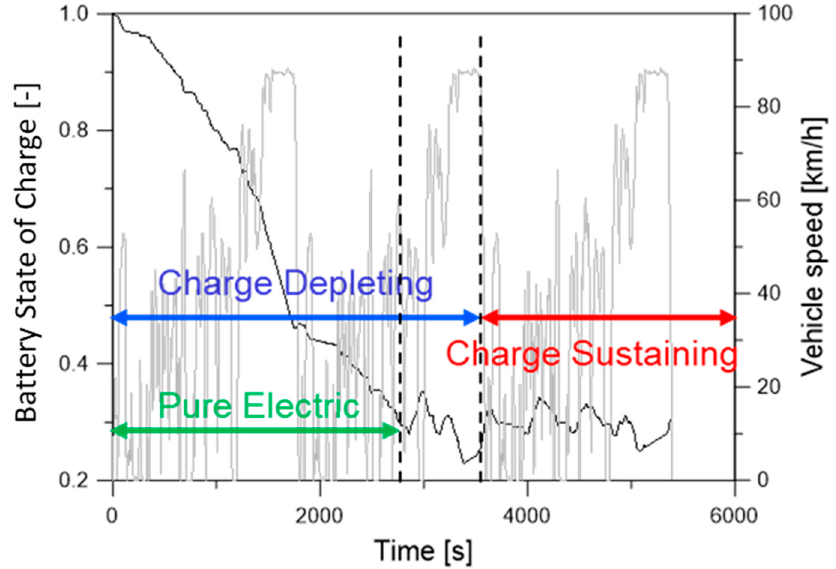
Figure 7. Cycle test for the PHEV. The phase pure electric mode, charge depleting, and charge sustaining are marked as a function of the ba tt ery state of charge (SOC).